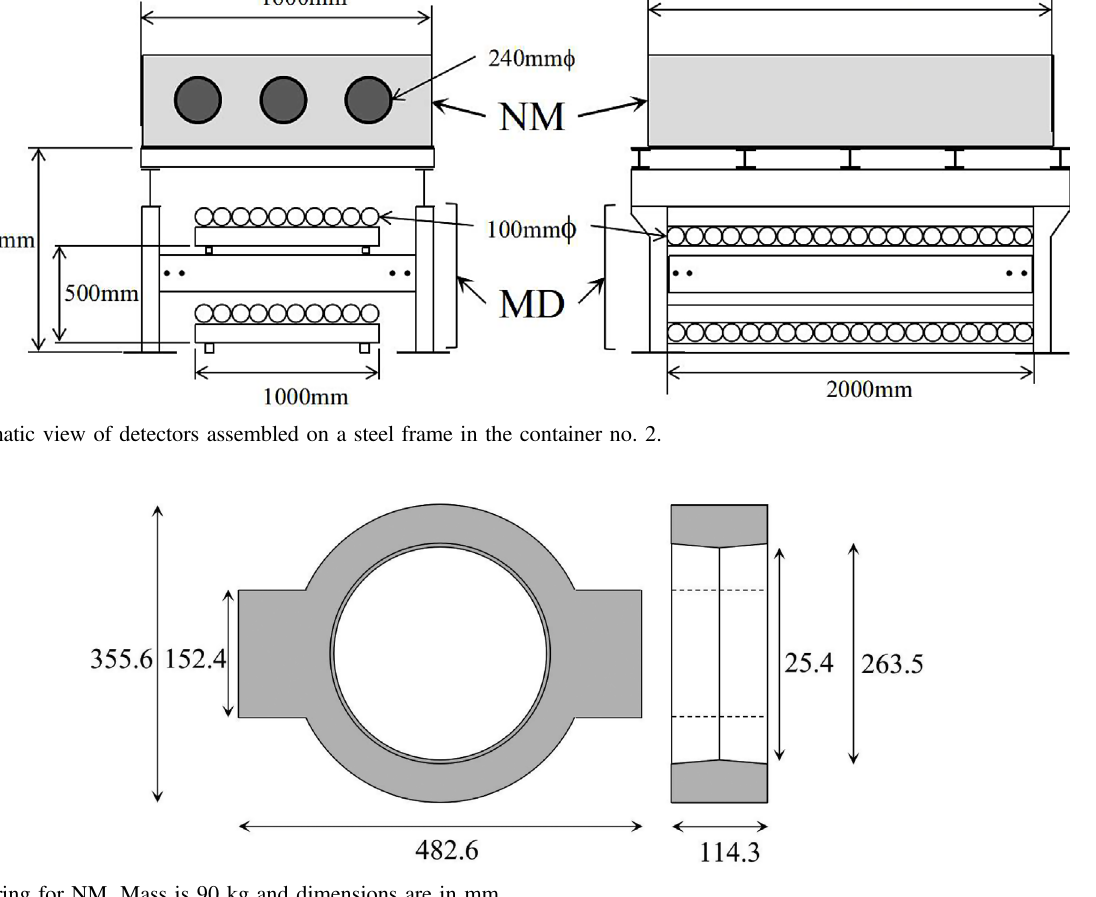
Fig. 3. Lead ring for NM. Mass is 90 kg and dimensions are in